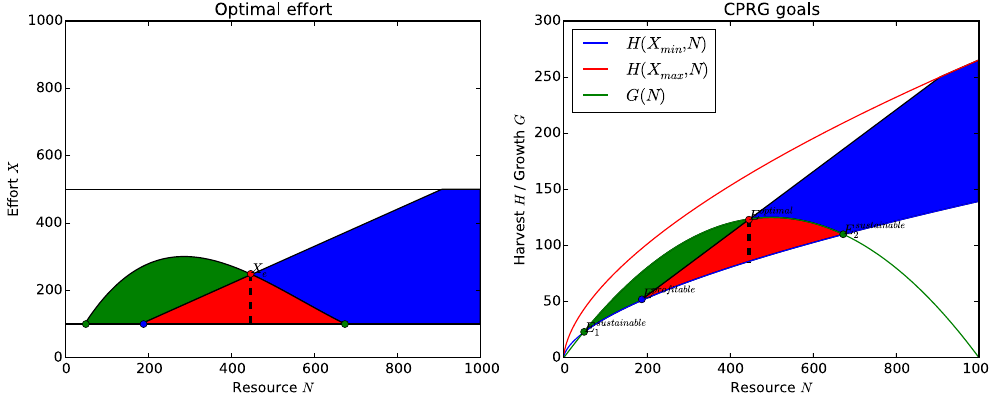
Figure 4. Integrating Figs 2 and 3 into a full socio-ecological system. The green and blue dots are the sustainability and profitability equilibria respectively, i.e. the resource levels below or above which sustainable/ profitable harvest is not possible any more. The red dot is the optimal equilibrium, at which the largest volume of distinct actions leads to sustainable and profitable harvest. ( a ) The bounds for effort levels that yield a profitable AND sustainable harvest are denoted by the red shaded area. ( b ) Resource dynamics with profitable and sustainable harvesting indicated by the red shaded area.